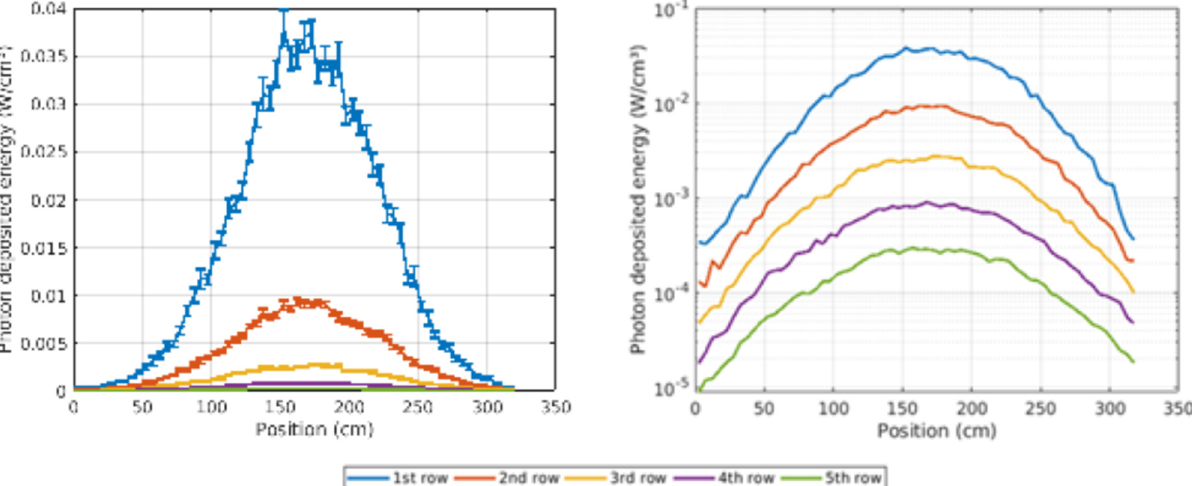
Fig. 23. Axial traverses of the photons deposited energy in the hexagonal tube of neutron shielding, linear scale (left), logarithmic scale